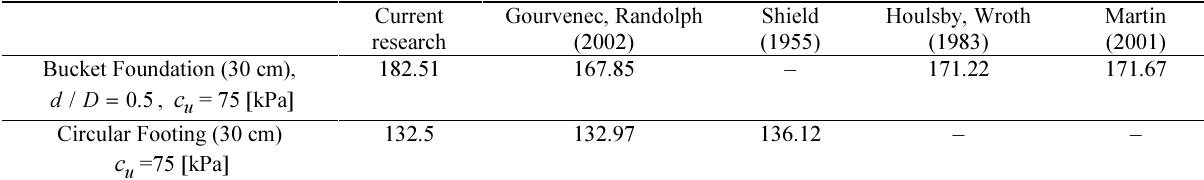
Table 12. Comparison to published